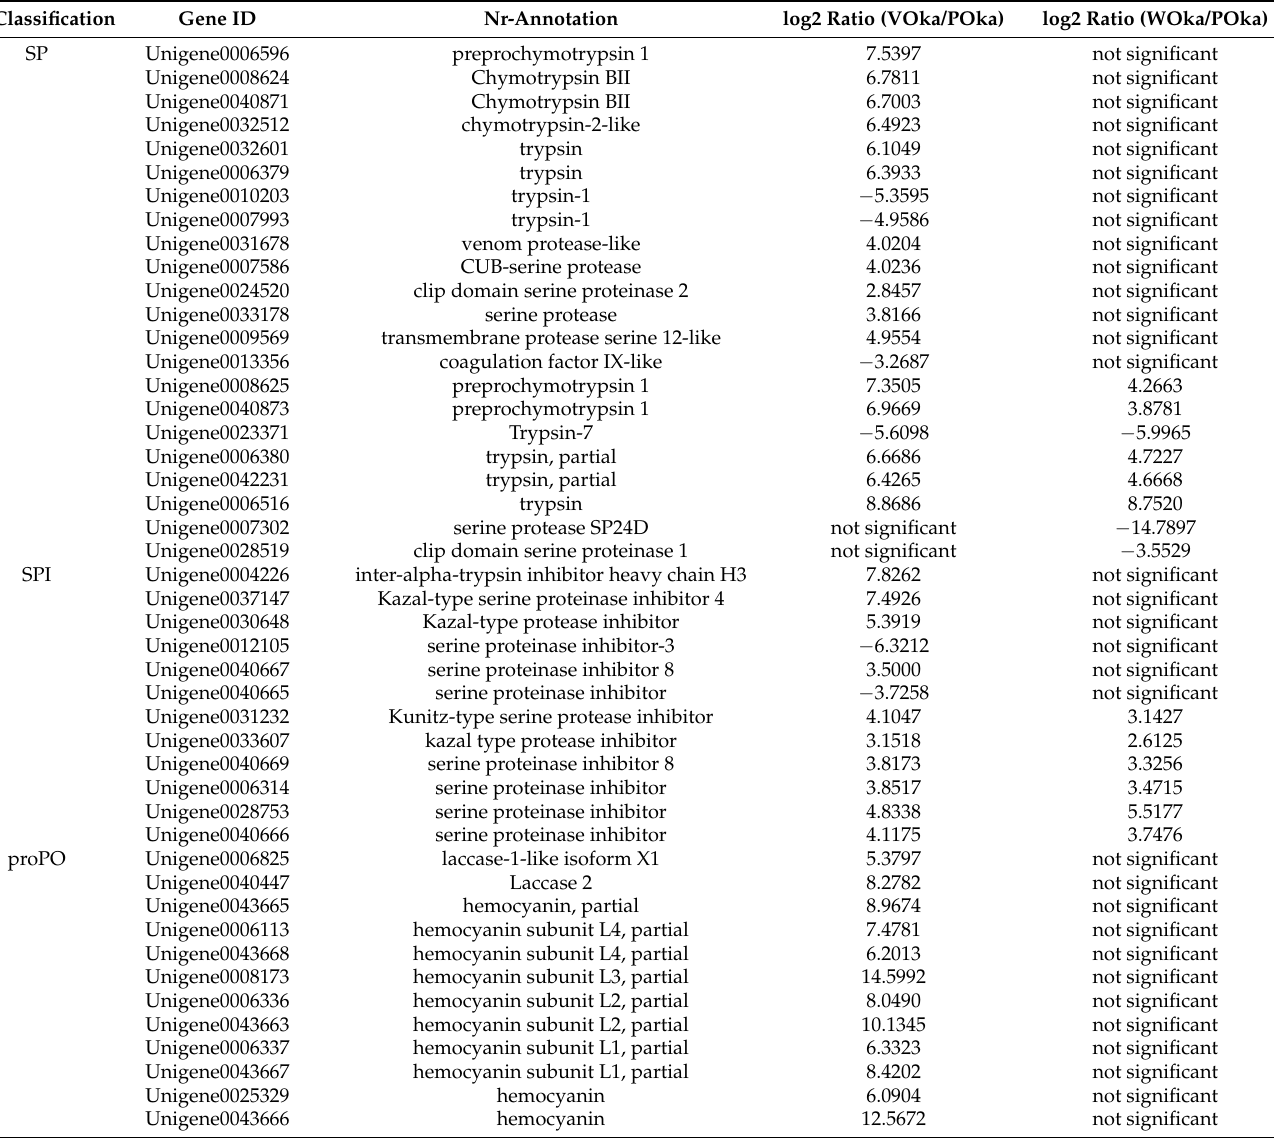
Table 3. DEGs related to the proPO system in the lymphoid organ after Vibrio or WSSV challenge.